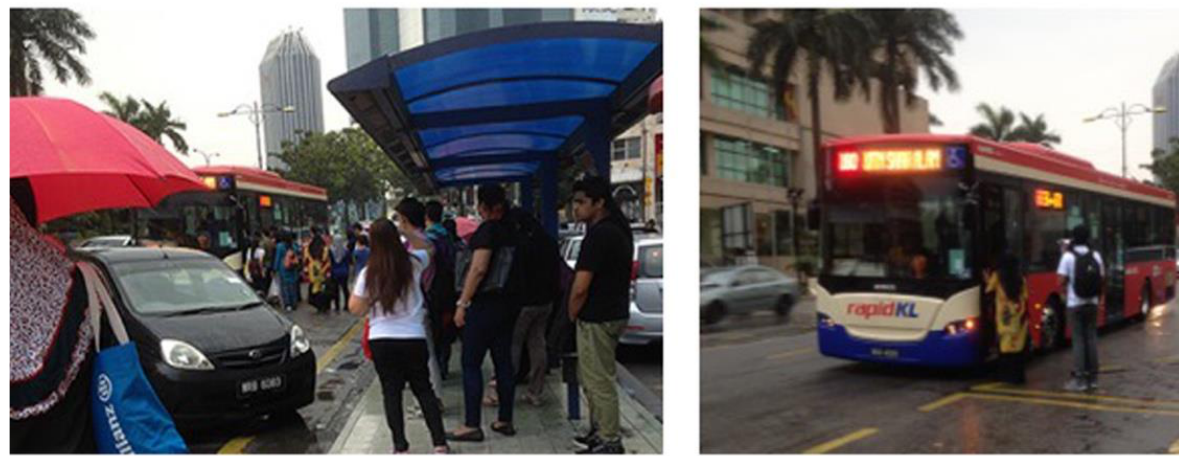
Figure 3. Delayed ingress during inclement weather in KL, Malaysia.